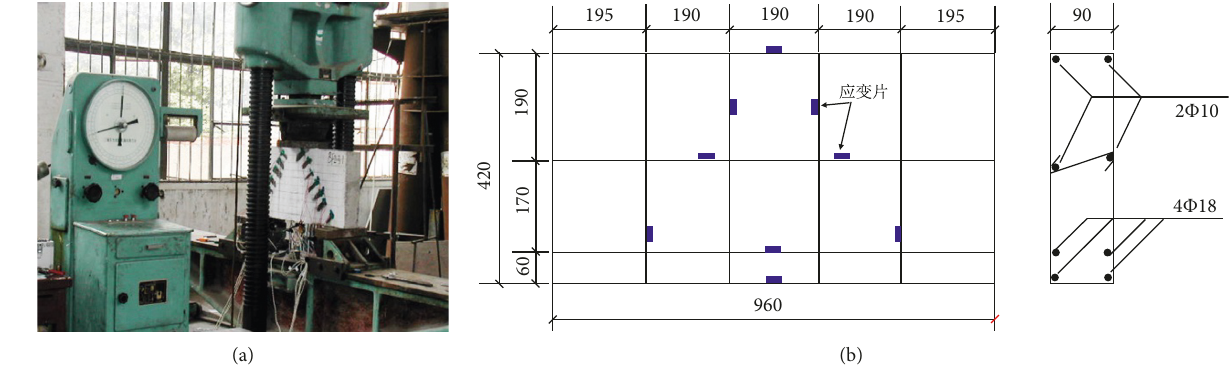
Figure 22: Experimental program. (a) Test setup. (b) Reinforcement